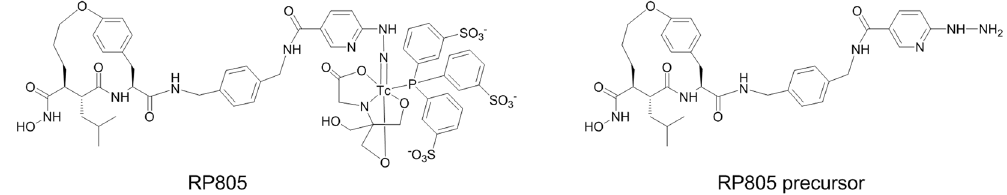
Figure 1. Structures of MMP-targeted SPECT imaging agent RP805 and its precursor.